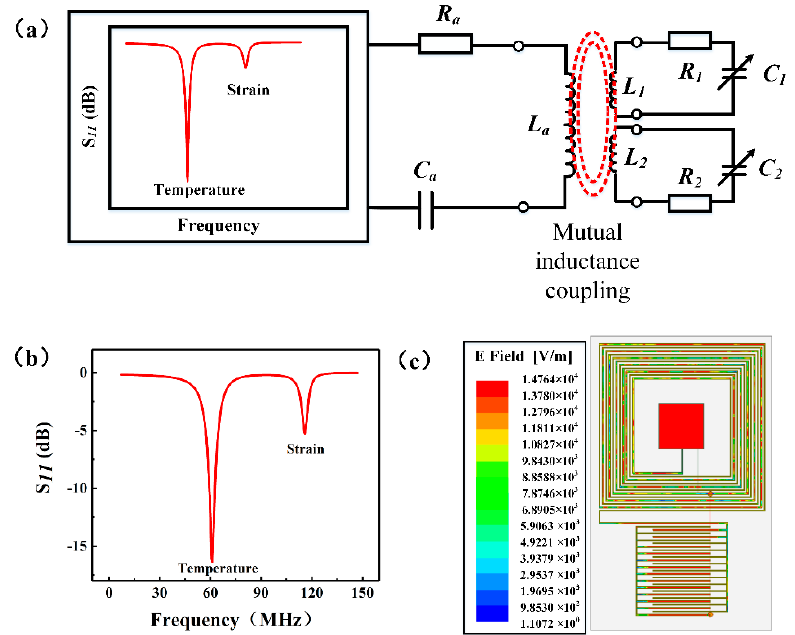
Figure 1. Design and simulation of integrated dual-parameter sensor: ( a ) Sensor’s equivalent circuit diagram; ( b ) Sensor’s f –S 11 simulation curve, and ( c ) Sensor’s simulated electric field distribution.